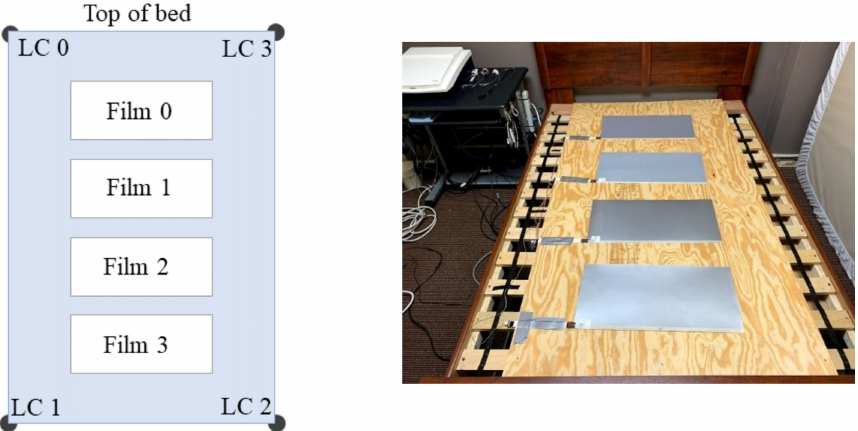
Figure 2. Approximate EMFi and load cell locations (not drawn to scale) ( left ) and the actual film locations ( right ), where the mattress has been removed and is leaning on the wall next to the